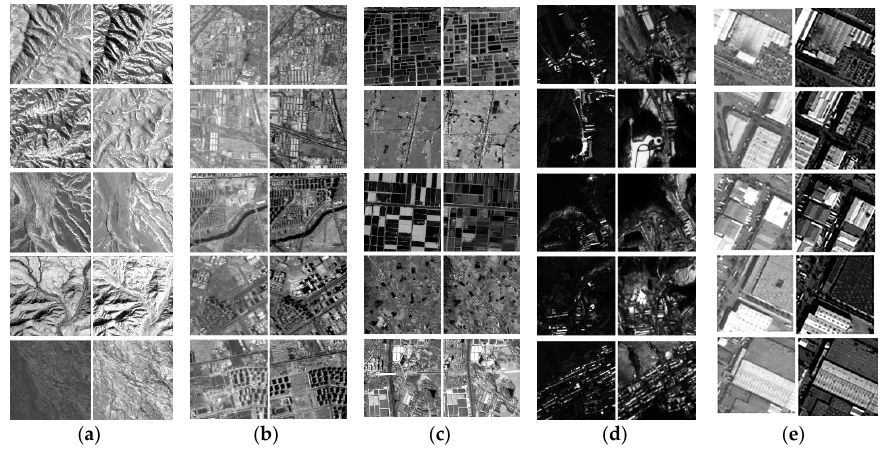
Figure 9. Sub-image pairs for estimating recall, precision, and number of correct matches: ( a ) Sub-image pairs from GF-1 and ZY-3 sensors; ( b ) GF-2 and ZY-3 sensors; ( c ) ZY3-NAD and ZY3-BWD sensors; ( d ) UAV and JL1 sensors; and ( e ) SPOT 5 and STOP 6 sensors.